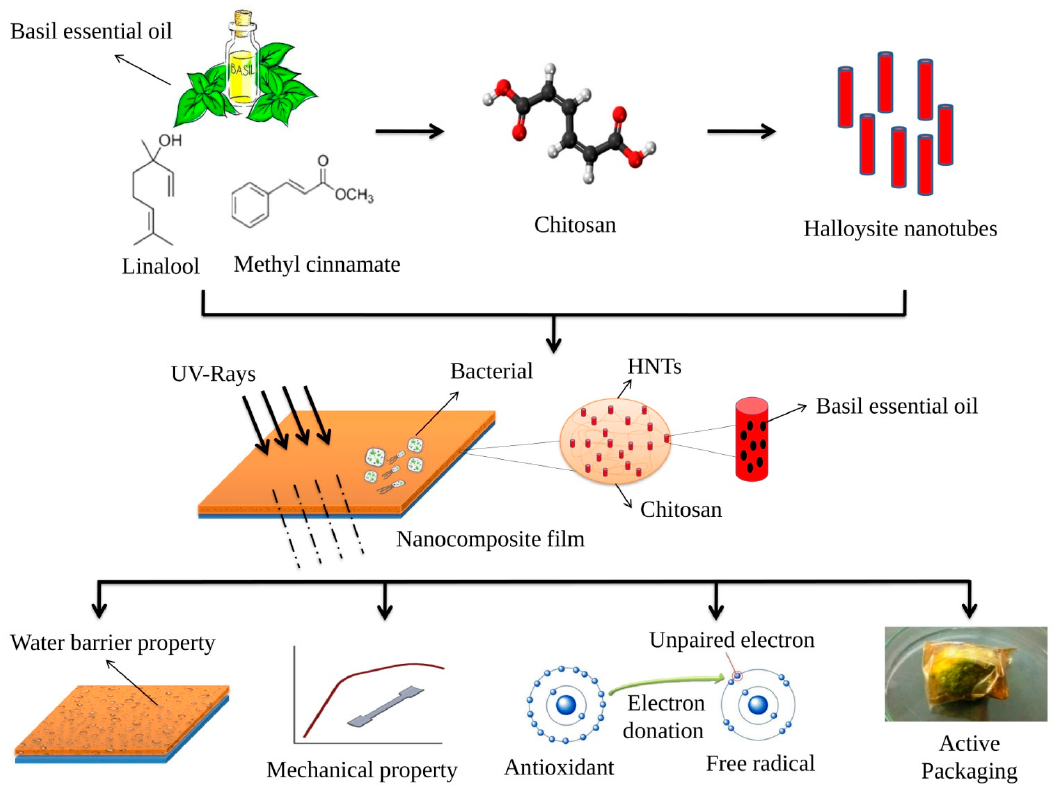
Figure 10. Schematic representation showing mechanism of Ch films formulated with HNTs and BEO improving qualities of the nanocomposite film.